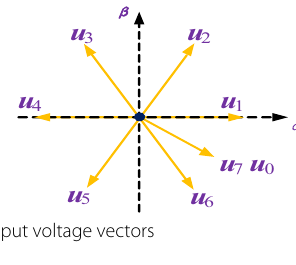
Fig. 3 The output voltage vectors